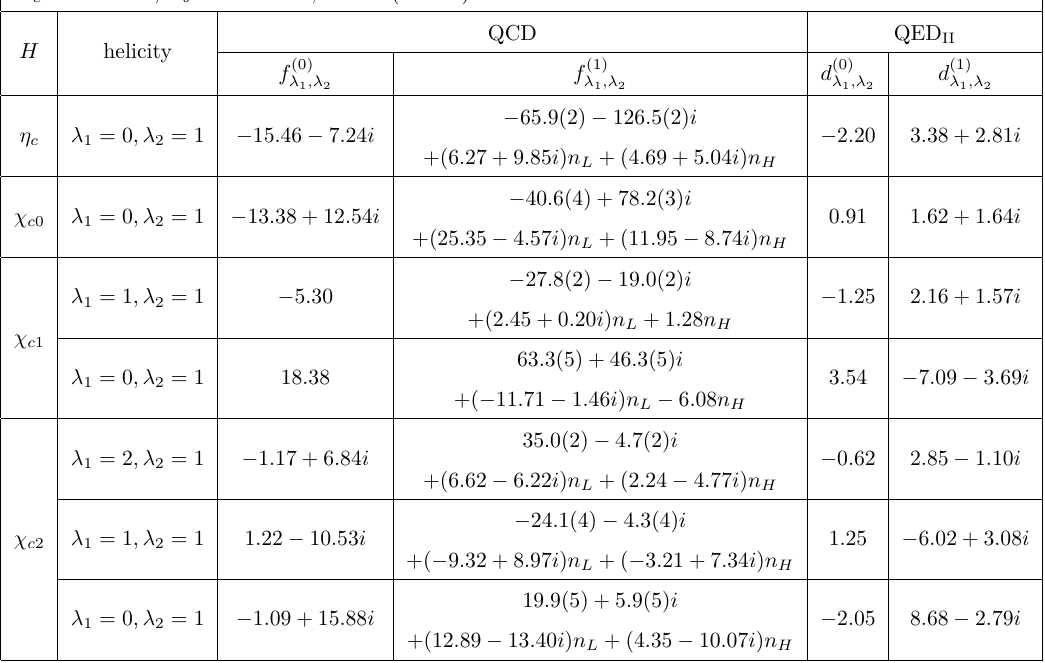
Table 2 . NRQCD predictions on the dimensionless helicity SDCs for m c = 1 . 68 GeV and m b = 4 . 78 GeV. We use the same conventions as table